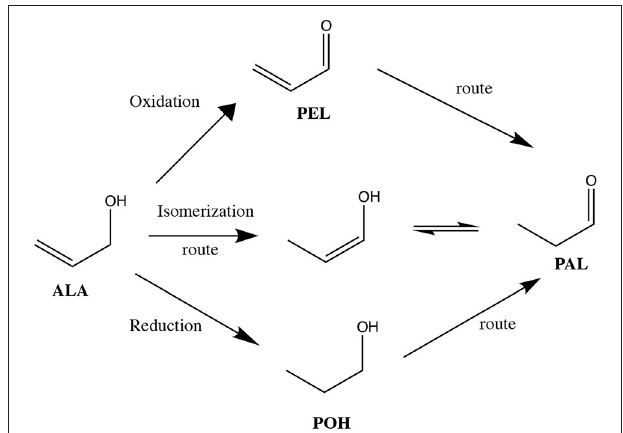
Frontiers in Chemistry |